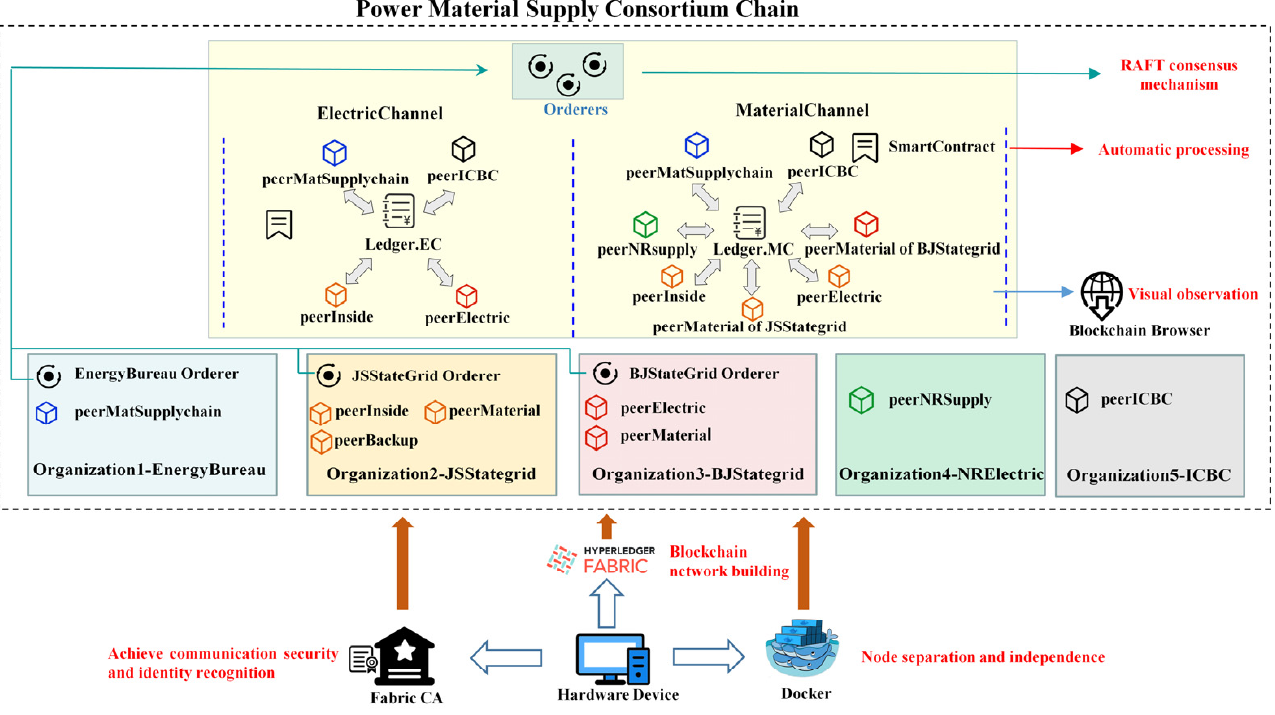
Figure 6. Power material blockchain test system based on Hyperledger Fabric.